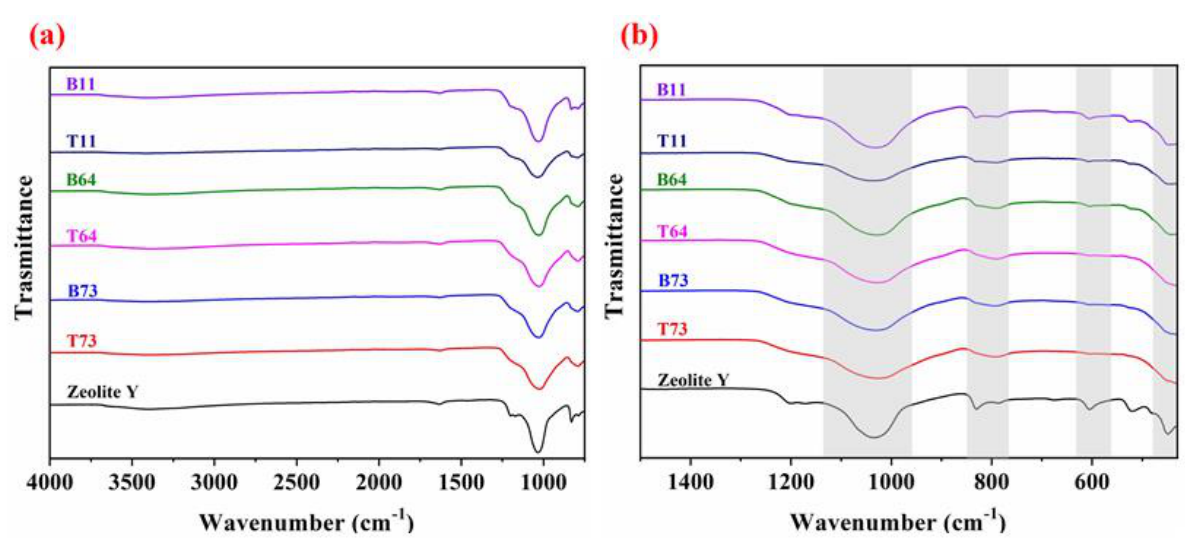
Figure 10. FT-IR spectra of the pristine zeolite Y and ball-milled CNF/zeolites in the wavelength range from ( a ) 4000 cm -1 to 600 cm -1 and ( b ) 1500 cm -1 to 430 cm -1.